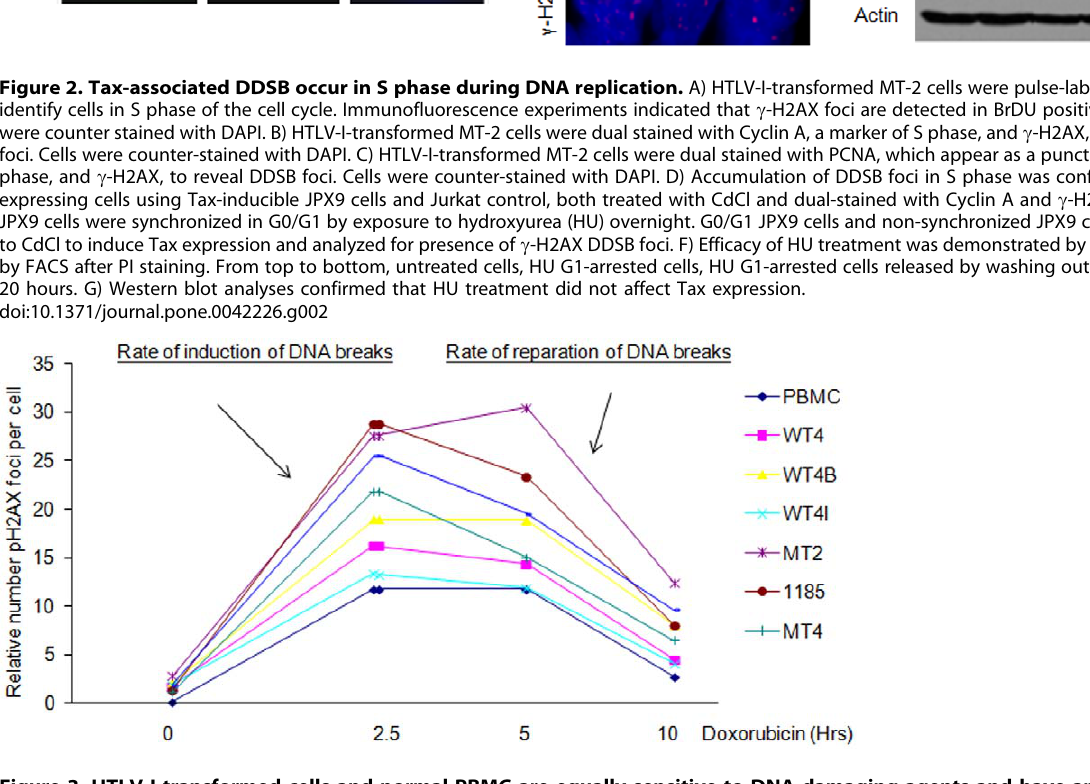
Figure 3. HTLV-I-transformed cells and normal PBMC are equally sensitive to DNA damaging agents and have an overall similar rate of DNA repair. HTLV-I-transformed cells (MT-2, MT-4, C8166, 1185) and Tax-immortalized cells (WT4, WT4B, WT4I) and PBMC were exposed to 10 nM of Doxorubicin, washed and rate of repair was evaluated by immunostaining of c -H2AX -revealed DDSB foci and quantified by microscopy at 0 h, 2.5 h, 5 h and 10 h after treatment. Because of various numbers of breaks in the absence of treatment, DNA breaks were normalized at 0 for time T=0. Data were generated from counting 100 cells. Rate of repair is represented by the decreasing number of c -H2AX foci at 2.5, 5 and 10 hours after doxorubicin treatment. Data were generated from counting 100 cells. doi:10.1371/journal.pone.0042226.g003 PLOS ONE |